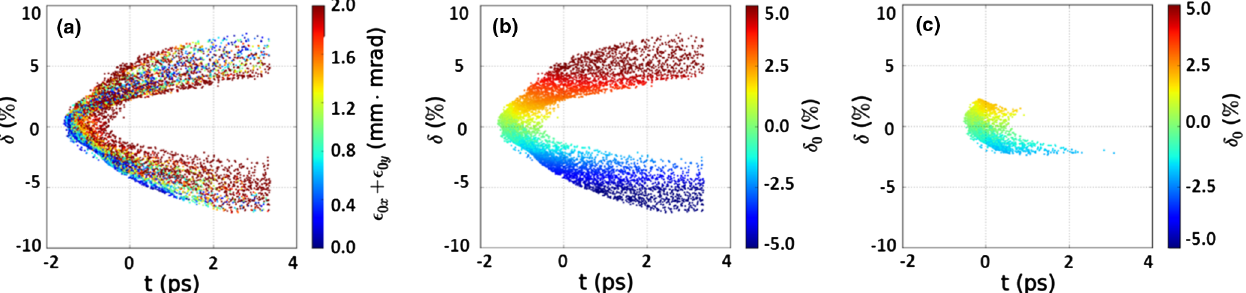
FIG. 11. The longitudinal phase spaces at the final focal point for one optimized result of the linac bunch compressor with LBNL ’ s þ ε VHF gun at 12 MeV. In plot (a), the particles are colored according to ε ¼ ε 0 0 y downstream of the accelerating cavities; in plot (b), x the particles are colored according to the energy spread downstream of the accelerating cavities; in plot (c), the particles with the initial energy spread in the range − 2% to þ 2% are colored according to the energy spread downstream of the accelerating cavities. The simulation code is IMPACT - T with both space charge effects and CSR effects being turned